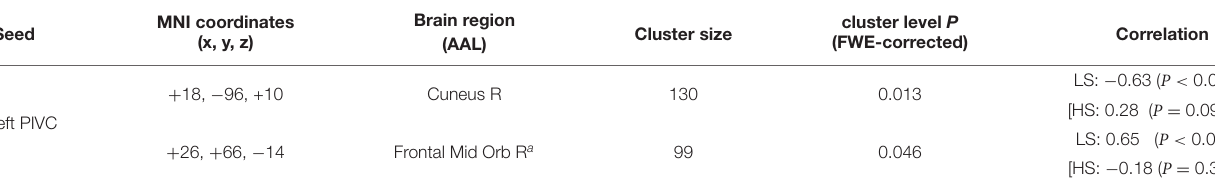
Brain region (AAL) Cluster size